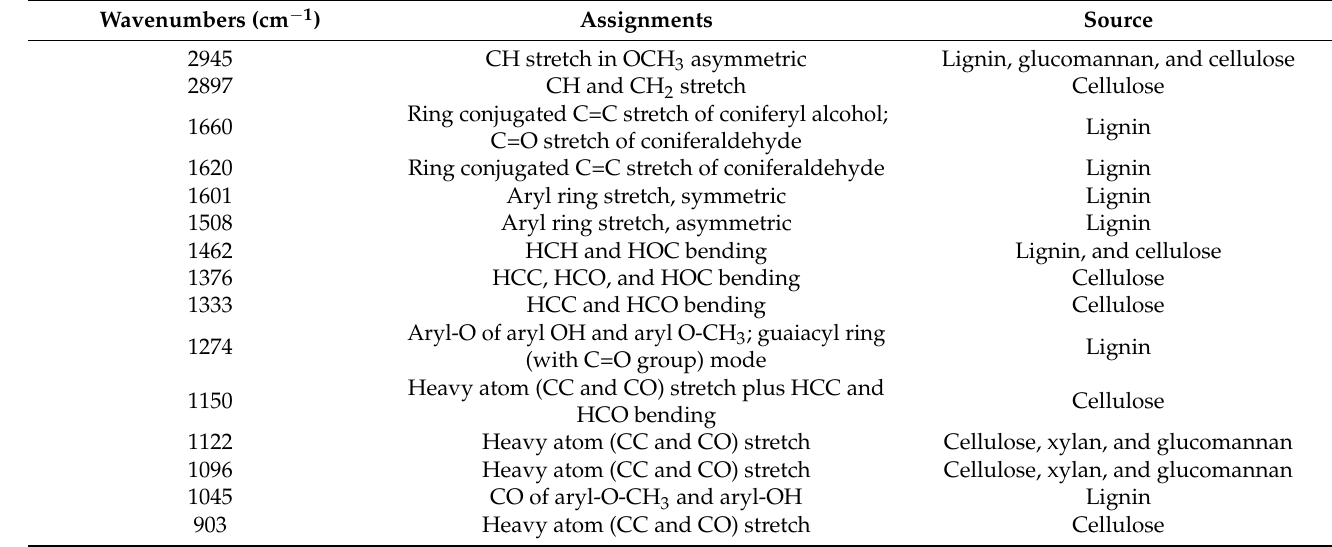
Table 4. Assignments of infrared bands in poplar ( Populus nigra × Populus deltoids )